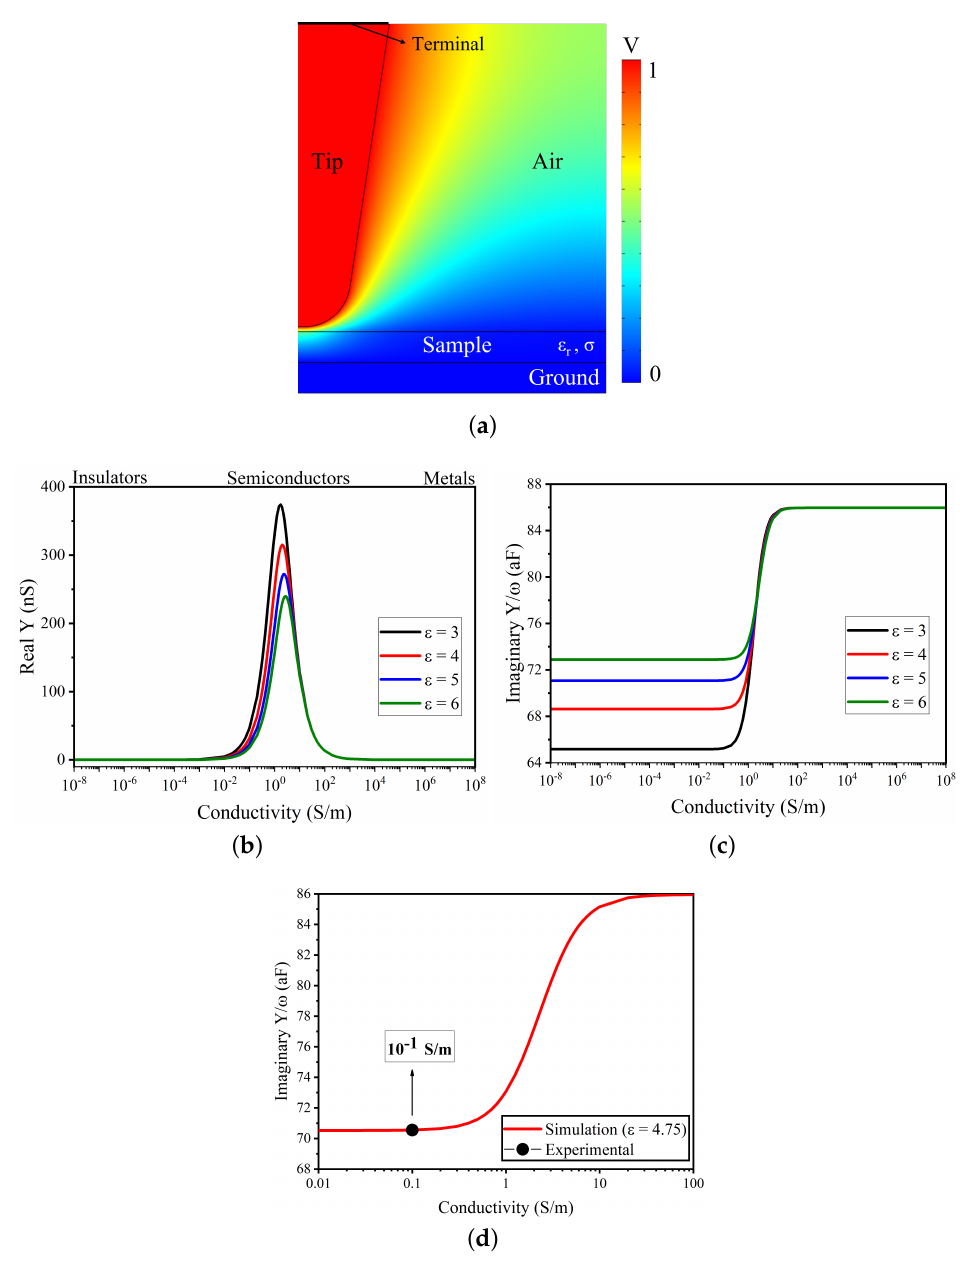
Figure 9. A 2D axis-symmetric model of the tip–sample system. ( a ) Potential field distribution and the tip–sample model. ( b ) Simulated response of Re (Y) for different (cid:101) r values. ( c ) Imaginary part of Im(Y)/ ω . ( d ) Simulated imaginary part of the Im(Y)/ ω of the tip–sample admittance at 5.99 GHz corresponding to an (cid:101) r value of 4.75 and compared with the calibrated experimental value of Im(Y)/ ω